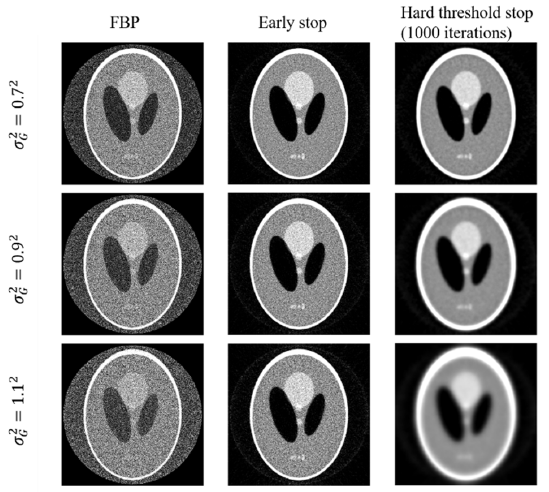
Figure 5. Reconstructed images by FBP ( left column ) and the joint ‐ parameter ‐ Bayes method with early stop ( middle column ) and hard threshold stop ( right column ). The display window is [0, 0.035] mm − 1 .